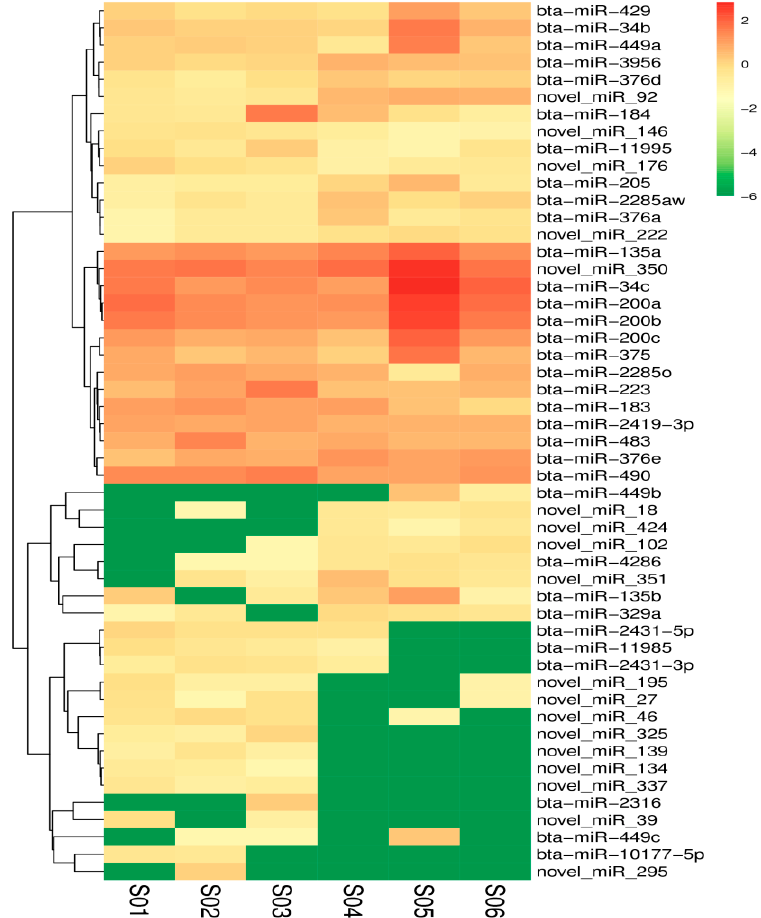
Figure 4. Heat map of the differentially expressed miRNAs in the CS and CON groups.